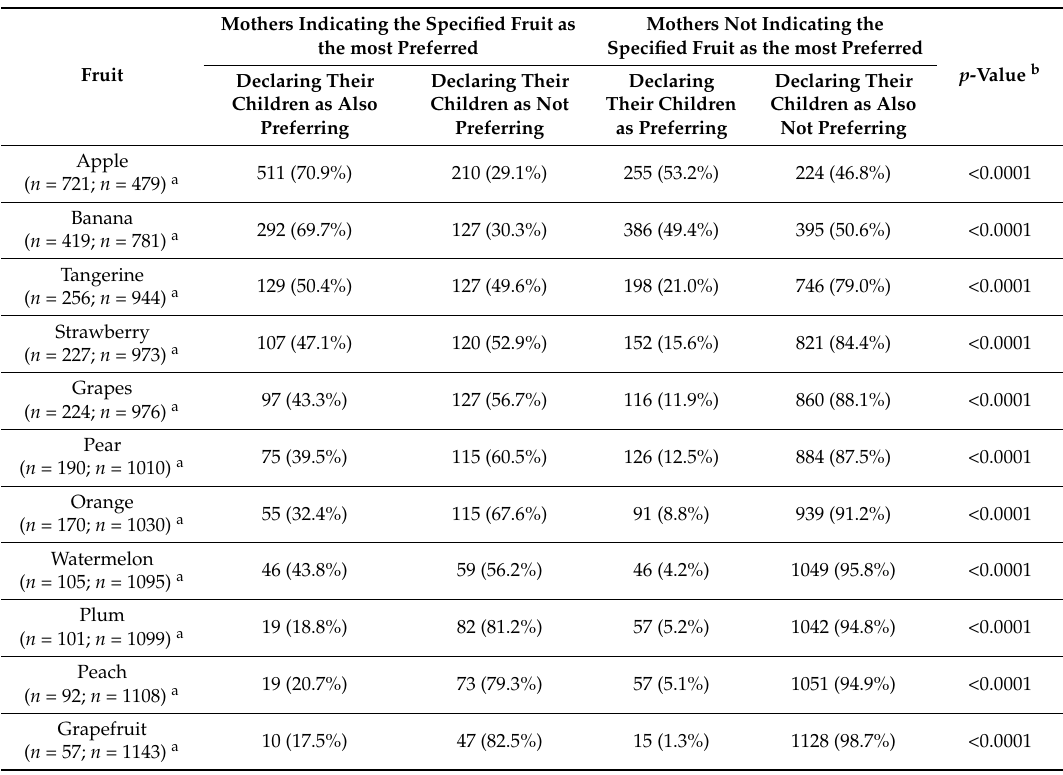
Table 3. Analysis of the association between the fruit preferences of mothers and their declared fruit preferences of their children in a national sample of Polish respondents ( n =